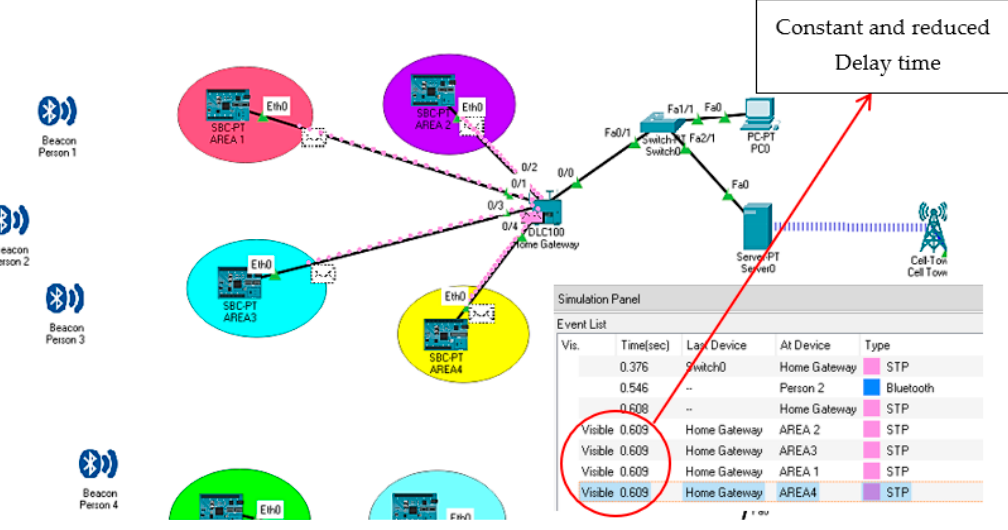
Figure 9. Discovery time of BLE device